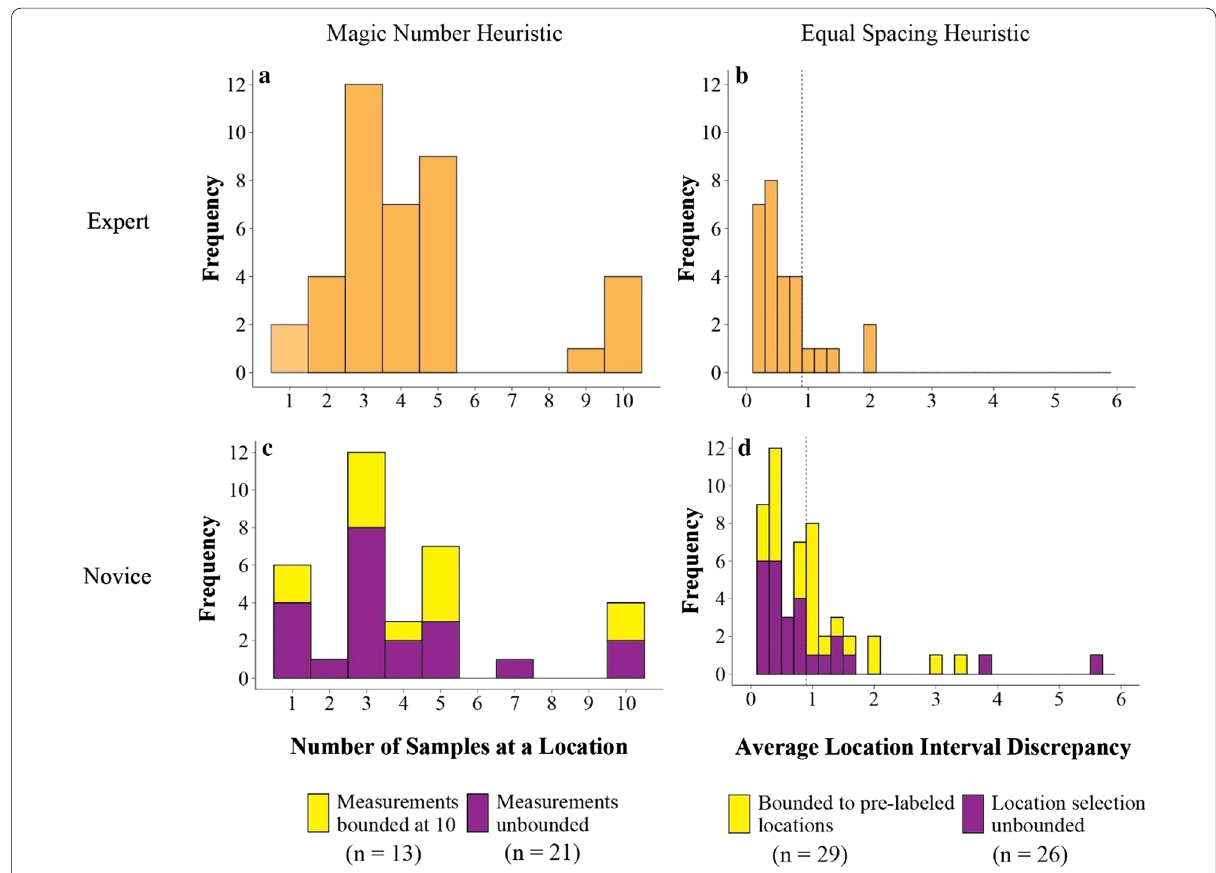
Fig. 5 Number of measurements taken at each location during initial strategy selection (magic number heuristic, right column) and average location interval discrepancy (equal spacing heuristic, left column) in expert geoscientist (top row) and novice undergraduate participants (bottom row). Average location interval discrepancy was computed by ordering interval sizes smallest to largest and taking the mean difference of intervals—a score of zero indicates perfectly uniform location intervals, and a threshold of one (dotted vertical line in plots B and D) was used to identify participants who selected non-uniform intervals. Novice undergraduates were randomly assigned to complete either bounded or unbounded versions of the task—participants were limited to 10 measurements per location and selecting from pre-labeled locations, or the number of measurements and location selection was unconstrained. Bounded versus unbounded conditions were included to test the extent to which constraints on measurement and location may have impacted sampling